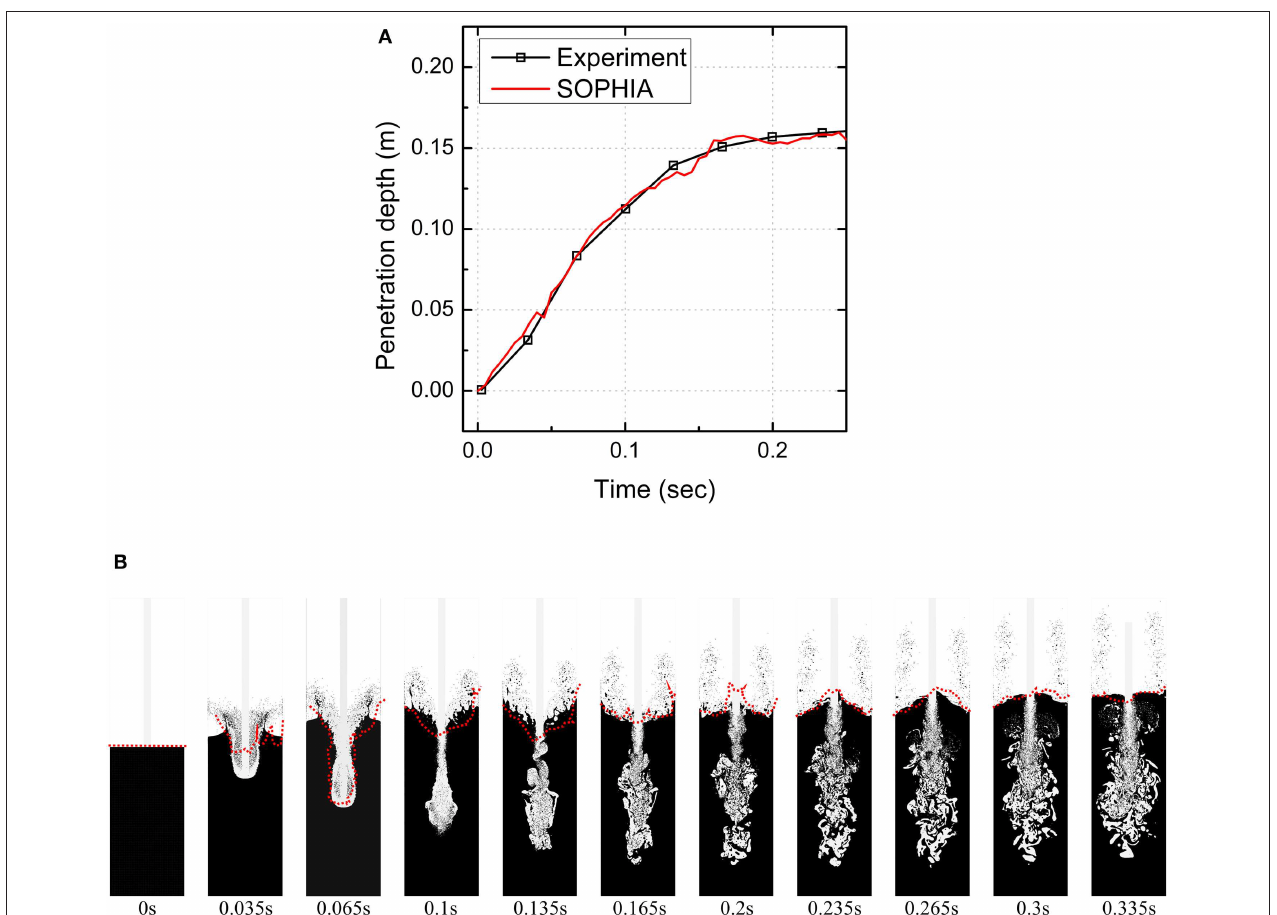
FIGURE 9 | Comparison of the simulation results with the experimental results: (A) comparison of the jet penetration depth and (B) comparison of the pool surface level with the experimental visualization (red lines for experimental results; Park et al.,